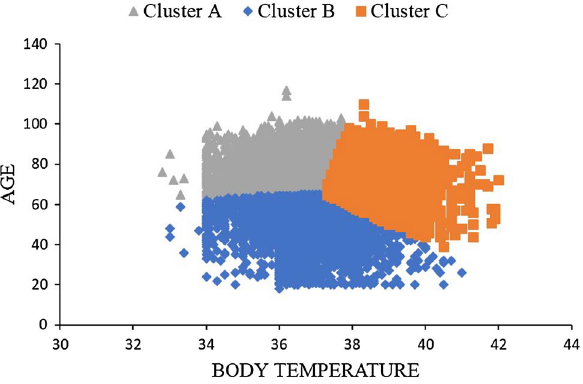
Figure 3. Distribution of the three patient clusters defined by age and body temperature.